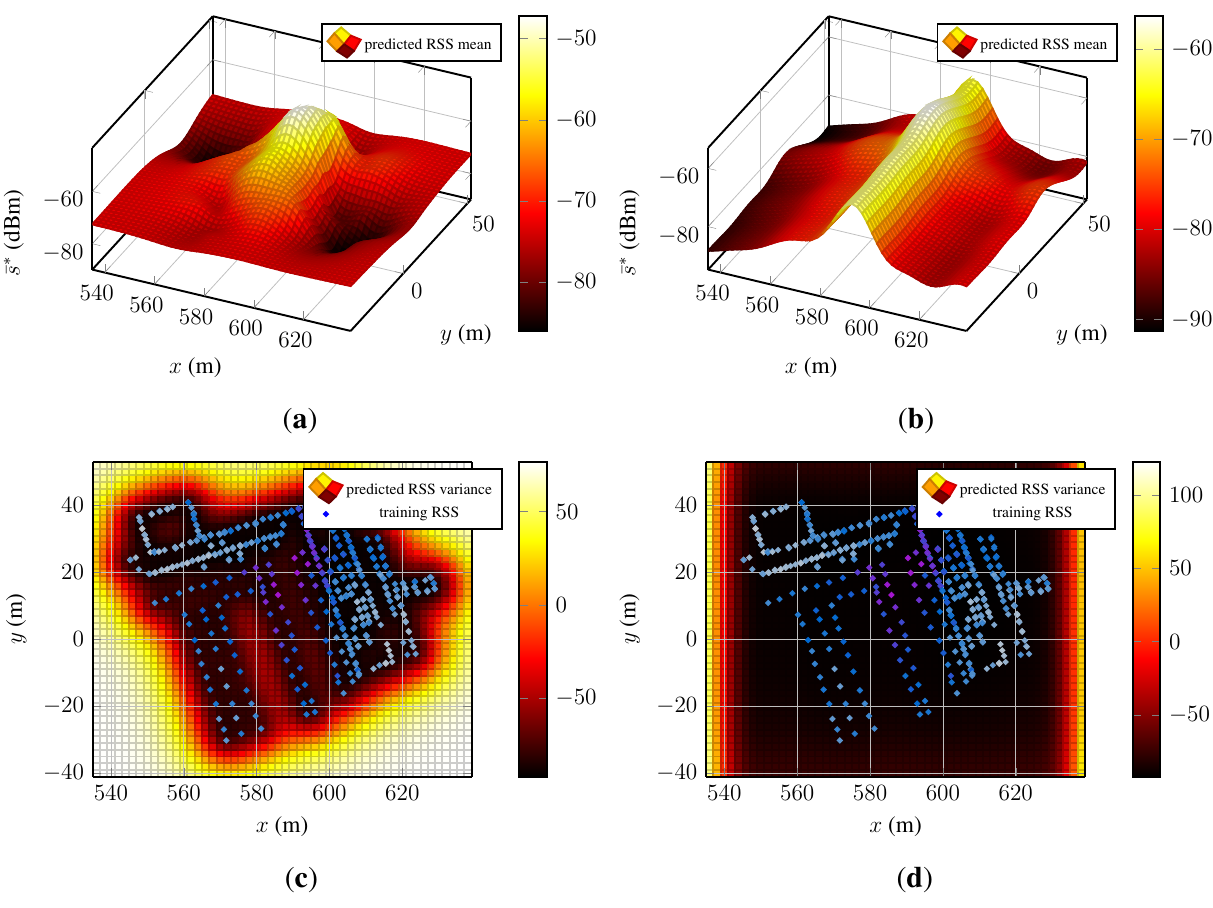
wave propagation.